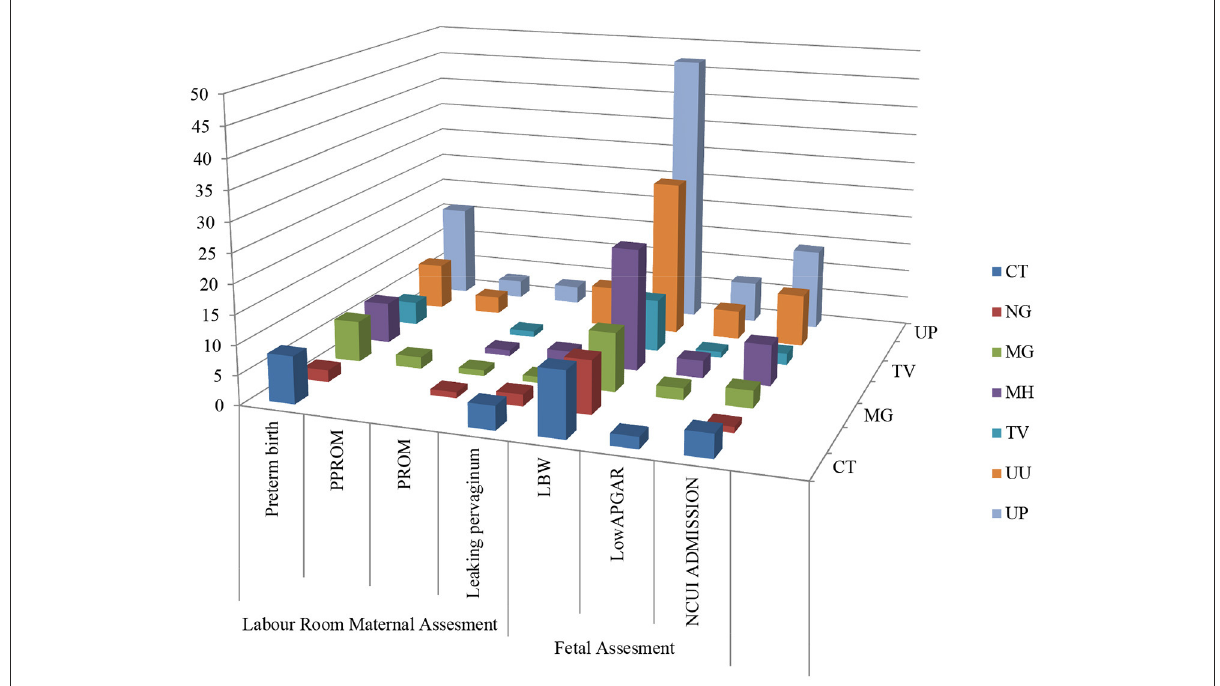
FIGURE6 Association between infection/ co-infection and maternal and natal related adverse events.